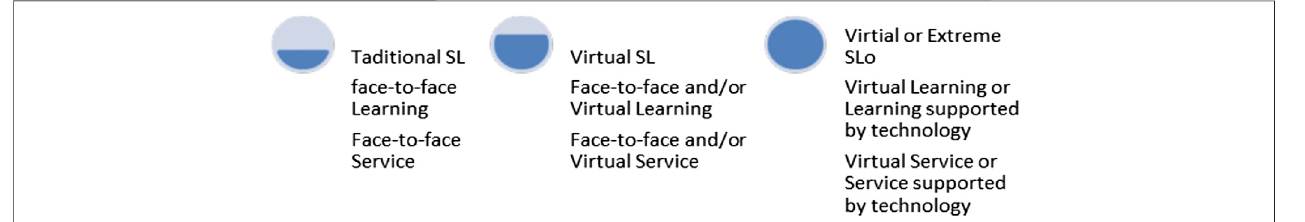
FIGURE 1 | Different types of Service Learning. Adapted from (Yusof, Azean, Harun and Doulatabadi,